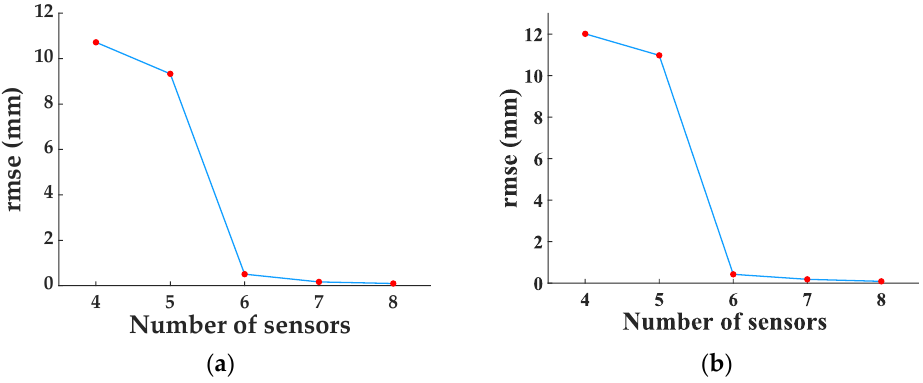
Figure 9. Influence of the number of sensors on accuracy, ( a ) X -direction, ( b ) Y -direction. Table 4. Influence of the number of sensors on accuracy.